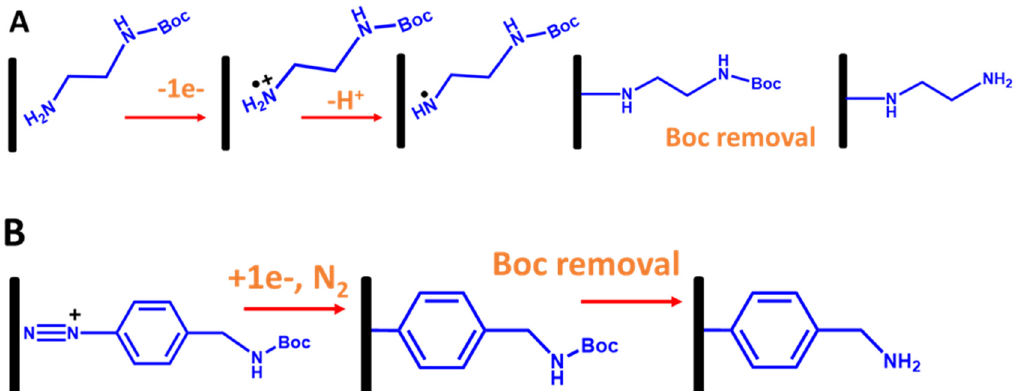
Figure 11. Schematic representation for stepwise electrografted primary amine and aryl linkers with Boc protecting groups onto the carbon electrode surfaces. ( A ) Electrografting of primary amine linkers via oxidation of amine group and ( B ) electrografting of aryl linkers via reduction in aryl diazonium salt [56].